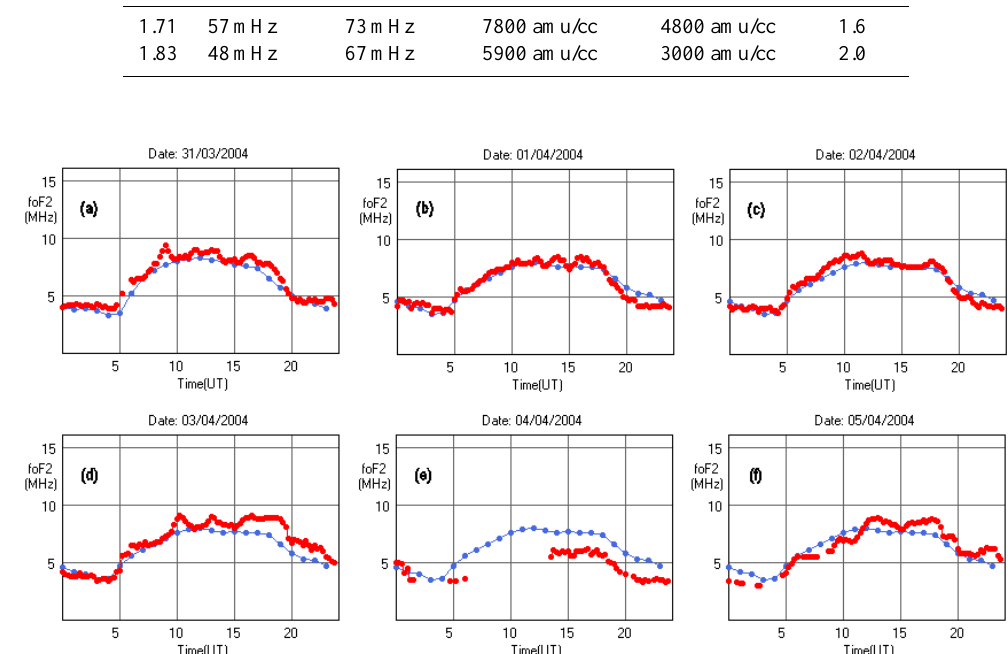
Fig. 6. Validated fo F2 values (in red), as obtained by the ionograms recorded in Rome from 31 March to 5 April 2004, compared to the corresponding fo F2 hourly median values (in blue) predicted by SIRM model and here assumed as quiet-day